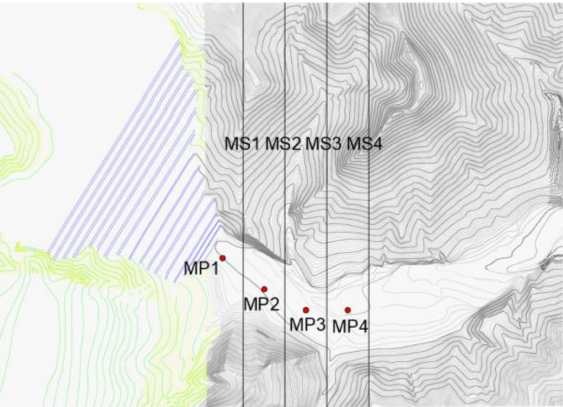
Figure 11. Monitoring section and monitoring point layout map.